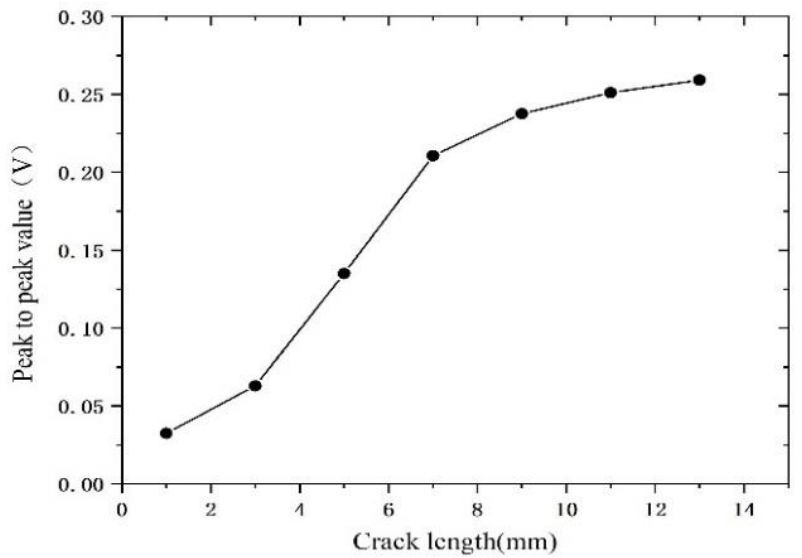
Figure 15. The peak to peak value of the probe’s test signal as a function of the crack length.